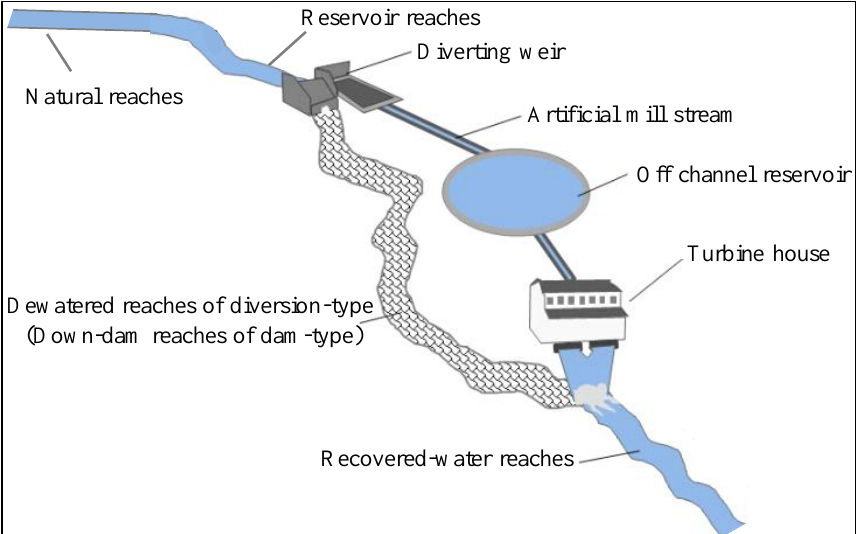
Figure 2. Schematic map of the diversion-type power station in the study (Modified from Guo et al . [3]). The seven rivers investigated in this study were the (1) Yanshan River (YSR, Yanshan